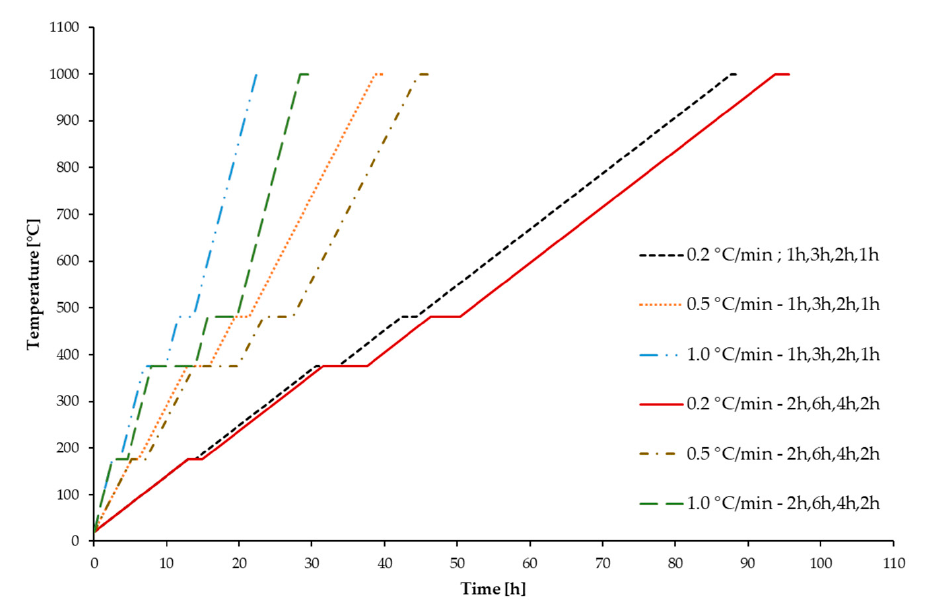
Figure 16. Debinding regimes explored.